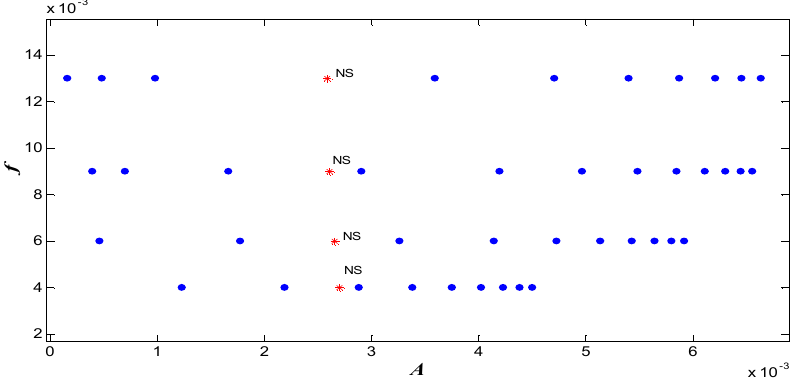
Figure 10. Bifurcation of forcing amplitude for different forcing frequencies.